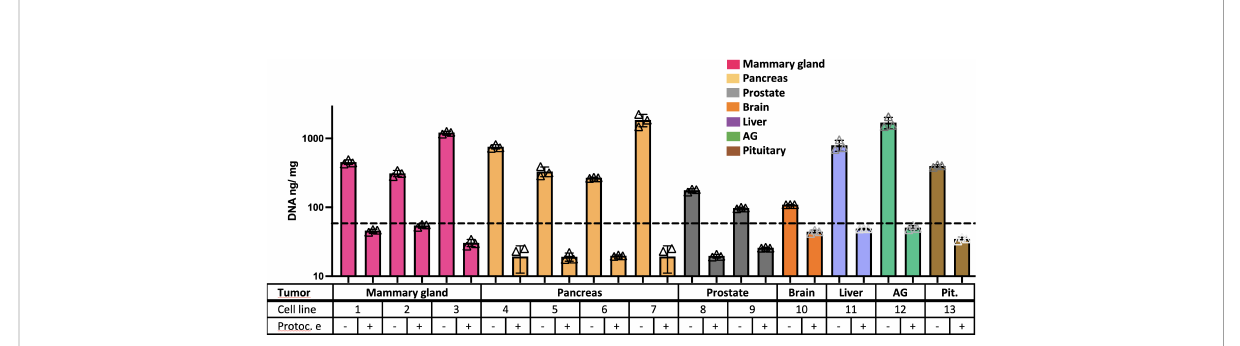
FIGURE 2 Freeze-EDTA-DNAse protocol decellularizes multiple tumor xenografts. DNA quanti fi cation data on control samples and “ e ” protocol-treated samples from multiple types of tumor xenografts ( n = 3). The dotted line indicates the 50-ng DNA/mg tissue threshold used to de fi ne successful decellularization. Note: cell line number codes are provided in Table